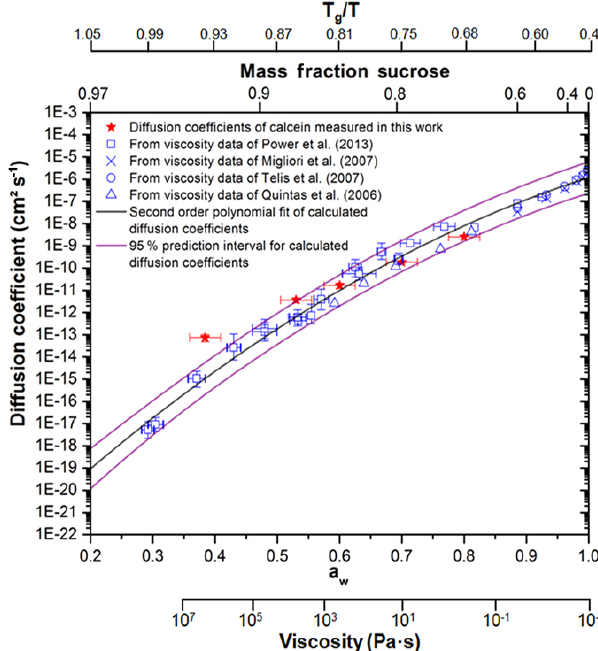
Figure 7. Comparison of measured diffusion coefficients of calcein in sucrose–water films from this work (red stars) with predicted diffusion coefficients based on measured viscosities of sucrose– water solutions and the Stokes–Einstein equation from Power et al. (2013) (blue squares), Migliori et al. (2007) (blue crosses), Telis et al. (2007) (blue circles) and Quintas et al. (2006) (blue triangles). The x error bars for this work correspond to the uncertainty in the determination of a w from the hygrometer. The y errors for this work correspond to 95% confidence intervals from measurement repeats. Several different x axes (wt% sucrose, a w , T g /T and viscosity) are included to help put the results in context. T represents the tem- perature of the experiment (294.5K), and T g represents the glass transition temperature of sucrose–water